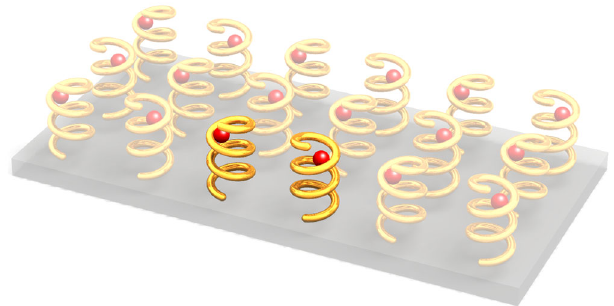
FIG. 1. To calculate the enantioselectivity in presence of chiral plasmonic structures, a modified dissymmetry factor g (cid:4) is used. The definition requires a superstructure composed of both of the enantiomers of the single chiral nanostructure. Chiral probe molecules of one handedness (sketched as red spheres) are placed at corresponding positions at each of the enantiomers where the near fields differ only in the sign of optical chirality when the incident polarization is